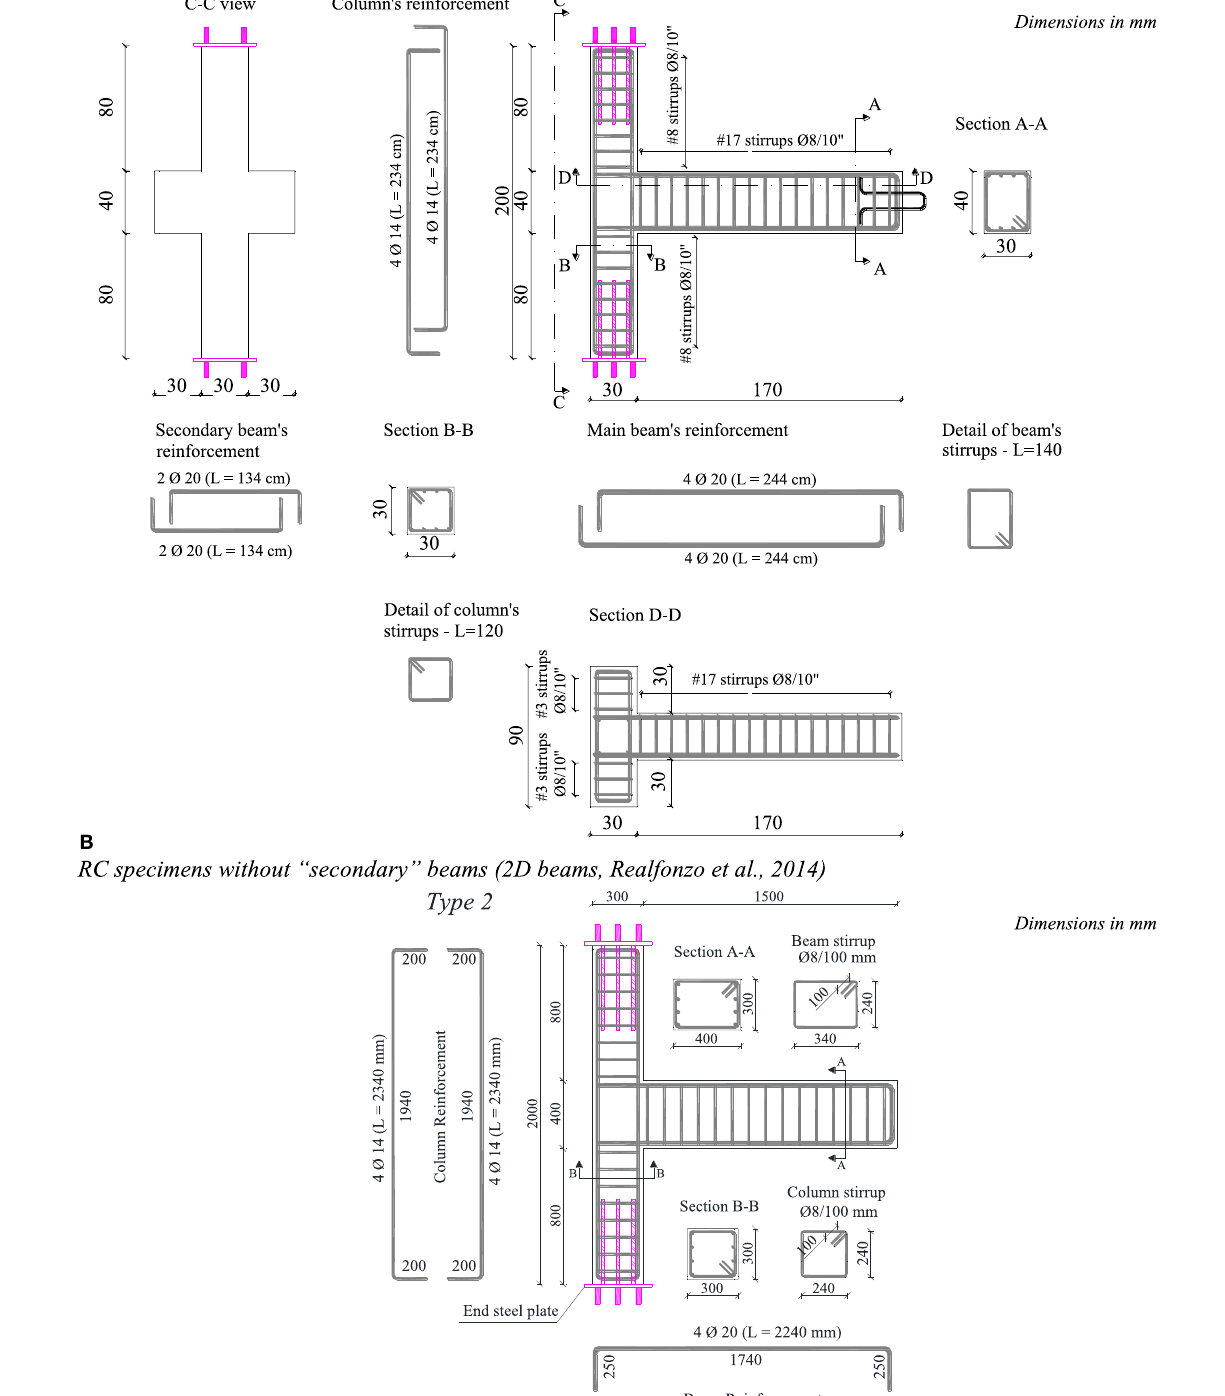
Frontiers in Materials |